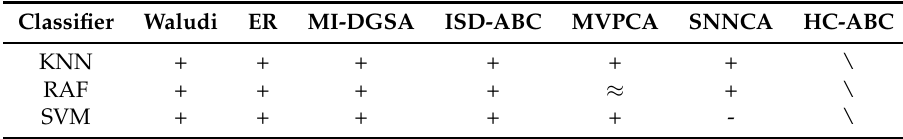
Table 5. The results of Post-hoc on the seven